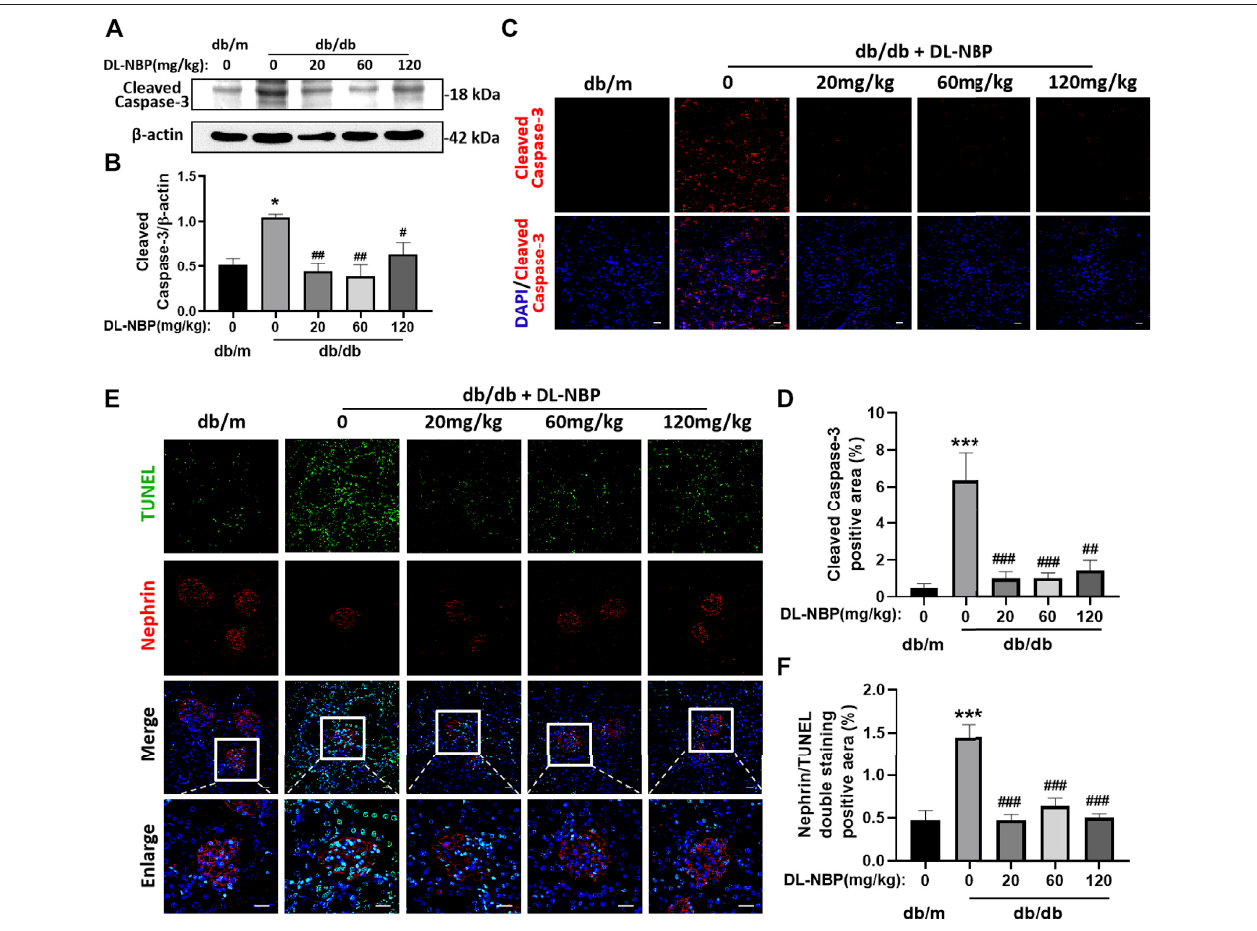
FIGURE 5 | DL-NBP treatment reduces diabetes-induced podocyte apoptosis in kidney. (A,B) Western blotting and quanti fi cation of Cleaved Caspase-3 expression in each group ( n (cid:2) 3). (C,D) Immuno fl uorescence staining of Cleaved Caspase-3 (red) in kidney of db/m (control) mice, db/db mice, DL-NBP mice (db/db mice were treated with 20, 60, or 120 mg · kg − 1 d − 1 of DL-NBP) (original magni fi cation × 400) ( n (cid:2) 5). Scale bar (cid:2) 20 μ m. (E,F) Co-staining of nephrin (red) and TUNEL (green) (original magni fi cation × 400) was used to detect the extent of cell apoptosis in each group ( n (cid:2) 5). Scale bar (cid:2) 20 μ m. TUNEL, TdT-mediated dUTP Nick- End Labeling. All data are presented as the mean ± SEM. * p < 0.05, *** p < 0.001 vs . db/m control; # p < 0.05, ## p < 0.01, ### p < 0.001 vs. db/db